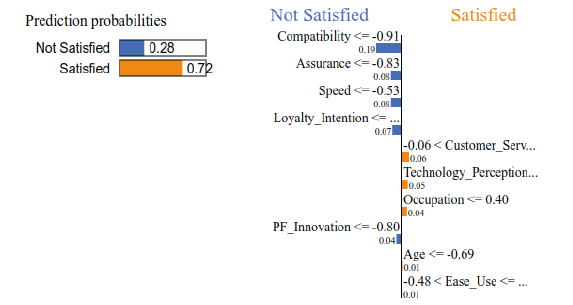
Figure 5. LIME—Explanation with